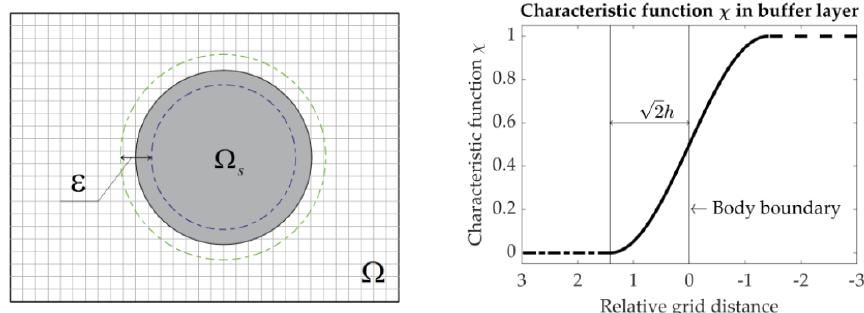
Figure 1. Definition of characteristic function 𝜒 .